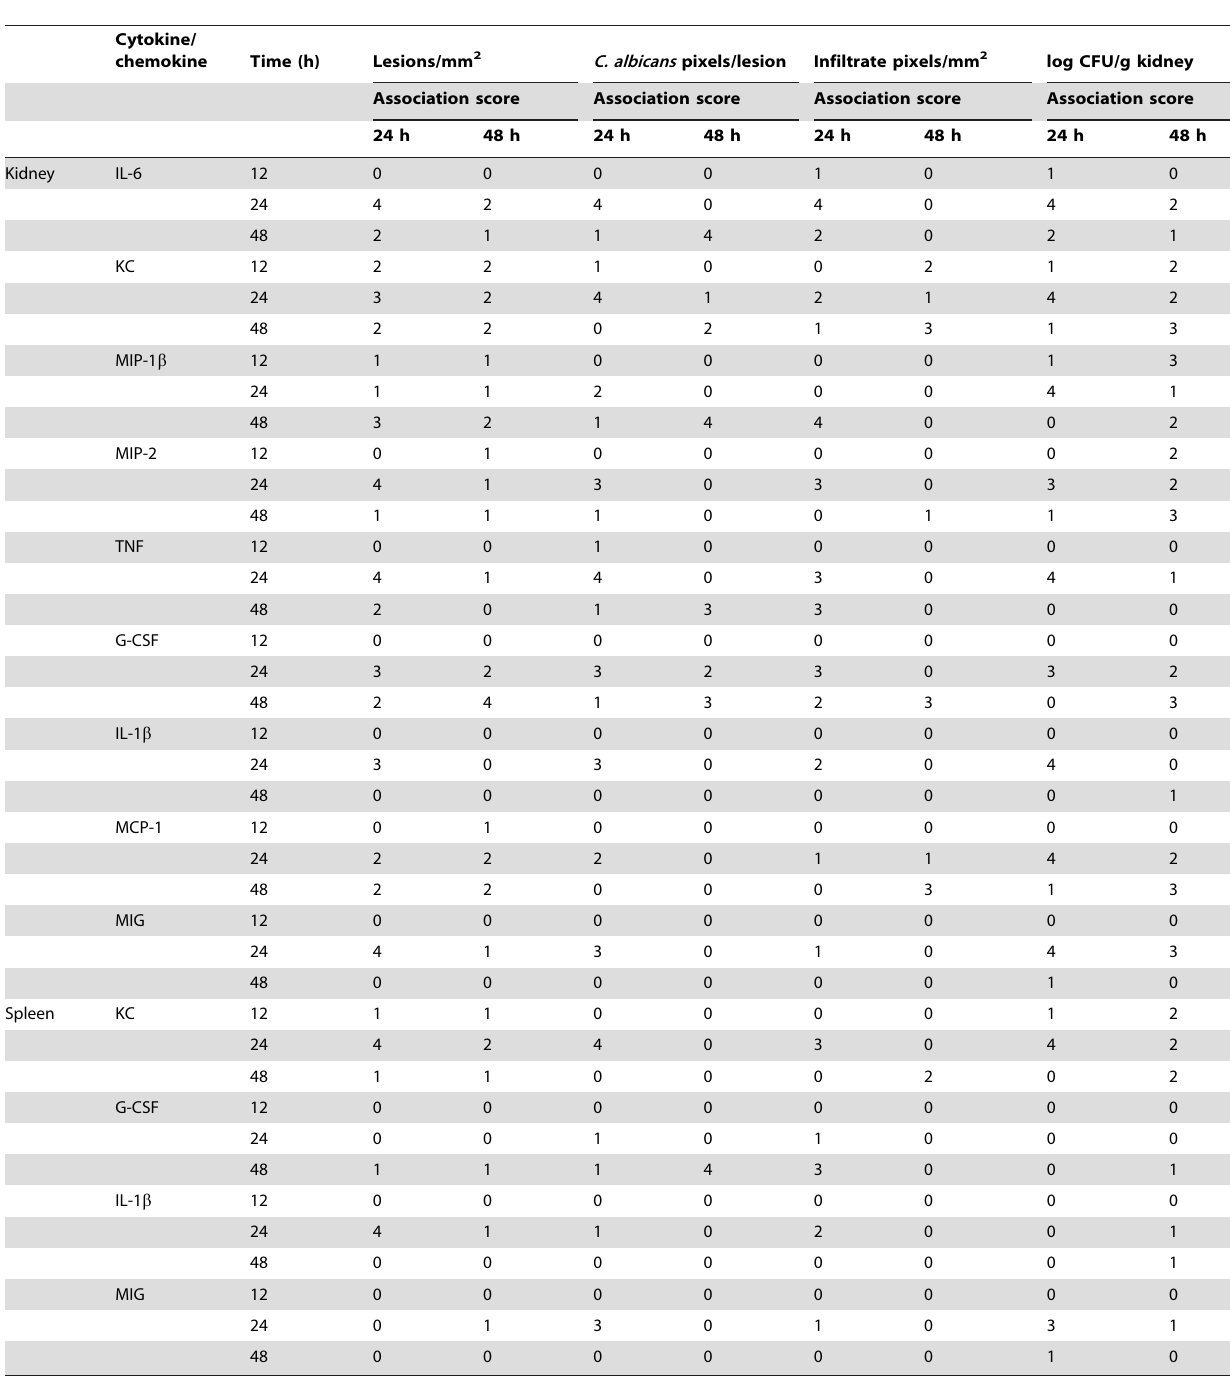
Table 4. Association scores showing the strength of correlation and ANOVA data between concentrations of cytokines or chemokines and parameters of C. albicans kidney